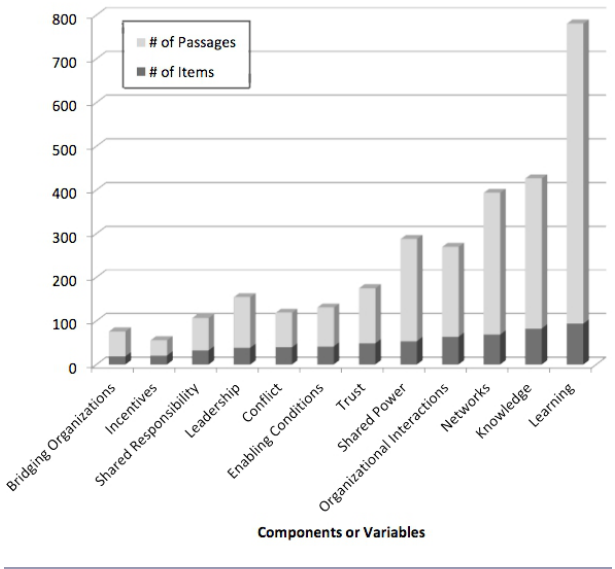
Fig. 3. Component or variables of interest emerging within adaptive comanagement.